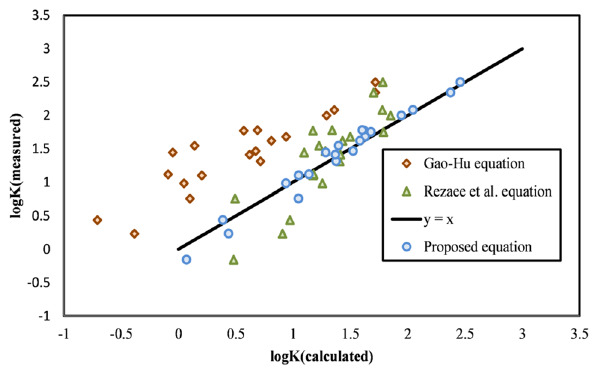
Fig. 8 Cross-plot of the measured and the calculated permeabilities for the proposed, Rezaee et al., and Gao and Hu equations (carbonate samples)